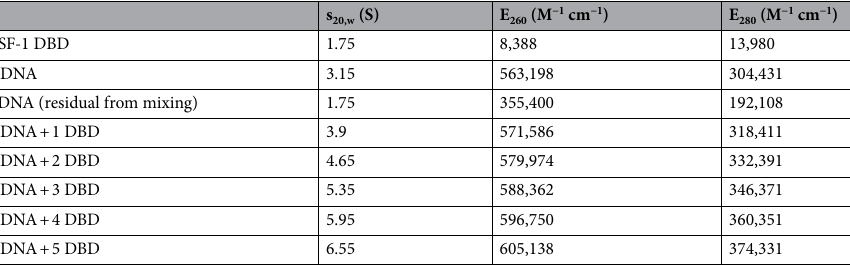
Table 7. Parameters used for custom grid fitting approach. Generally applicable sedimentation coefficients were obtained for this model system, where HSEs are embedded into probes of identical size. Extinction coefficients are also shown. f/f0 was kept floating during the fit with the custom grid model, while the s 20,w was set to allow only the species mentioned in this table.